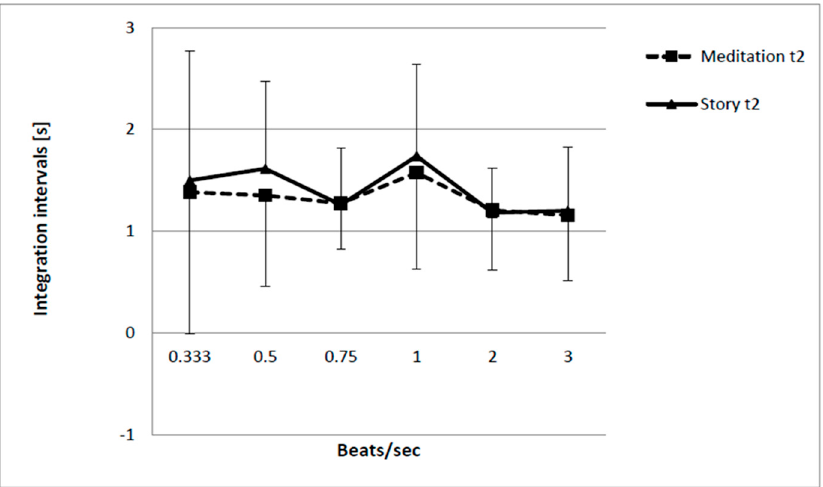
Figure A2. Perceived beats (integration interval) as a function of metronome frequency (beats/sec) after meditation (t2).